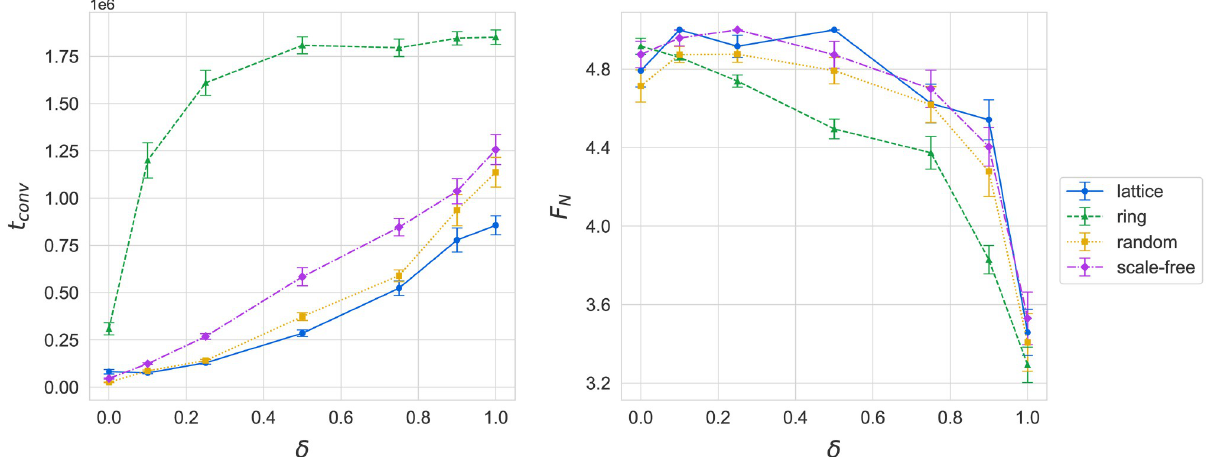
Fig 8. The effect of neighbor influence δ on the language dynamics of the model. Larger δ results in slower convergence and less optimal languages, except for the range δ 2 (0.1, 0.2), where F conv is maximized. Results are for N = 400, averaged over 24 runs each.